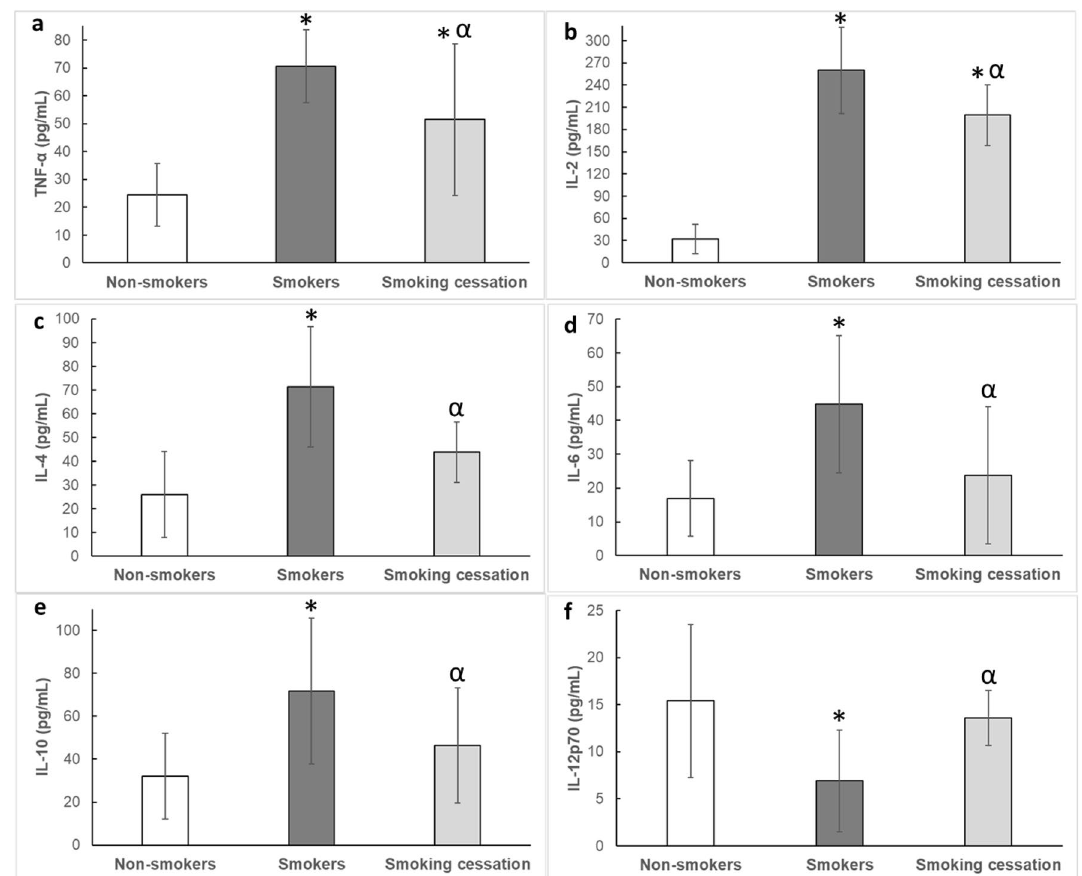
Figure 4. Effects of smoking and 14 days smoking cessation ( a ) TNF-α: tumour necrosis factor-alpha; ( b ) IL-2: interleukin-2; ( c ) IL-4: interleukin-4; ( d ) IL-6: interleukin-6; ( e ) IL-10: Interleukin-10; ( f ) IL-12p70: interleukin- 12p70; data are presented as mean ± SD; *: significantly different from Non-smokers at p < 0.05; α: significantly different from smokers at p < 0.05.